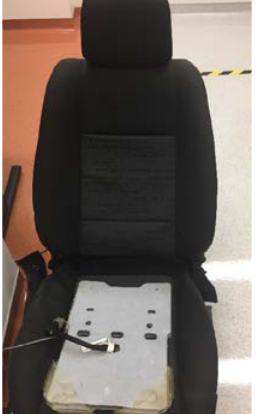
Figure 1. Ford Mustang front passenger seat and seat sensor.